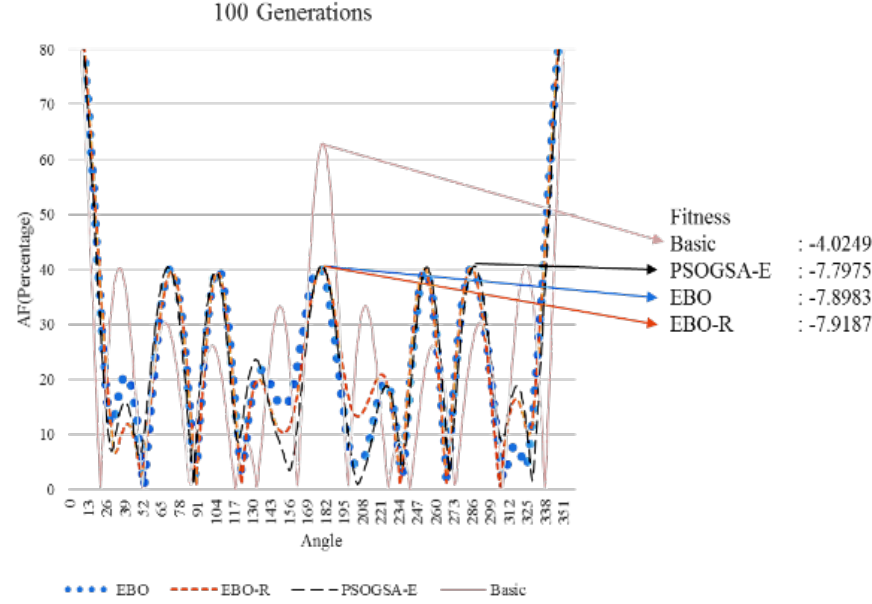
Figure 11. Beam patterns of different algorithms (100 generations).